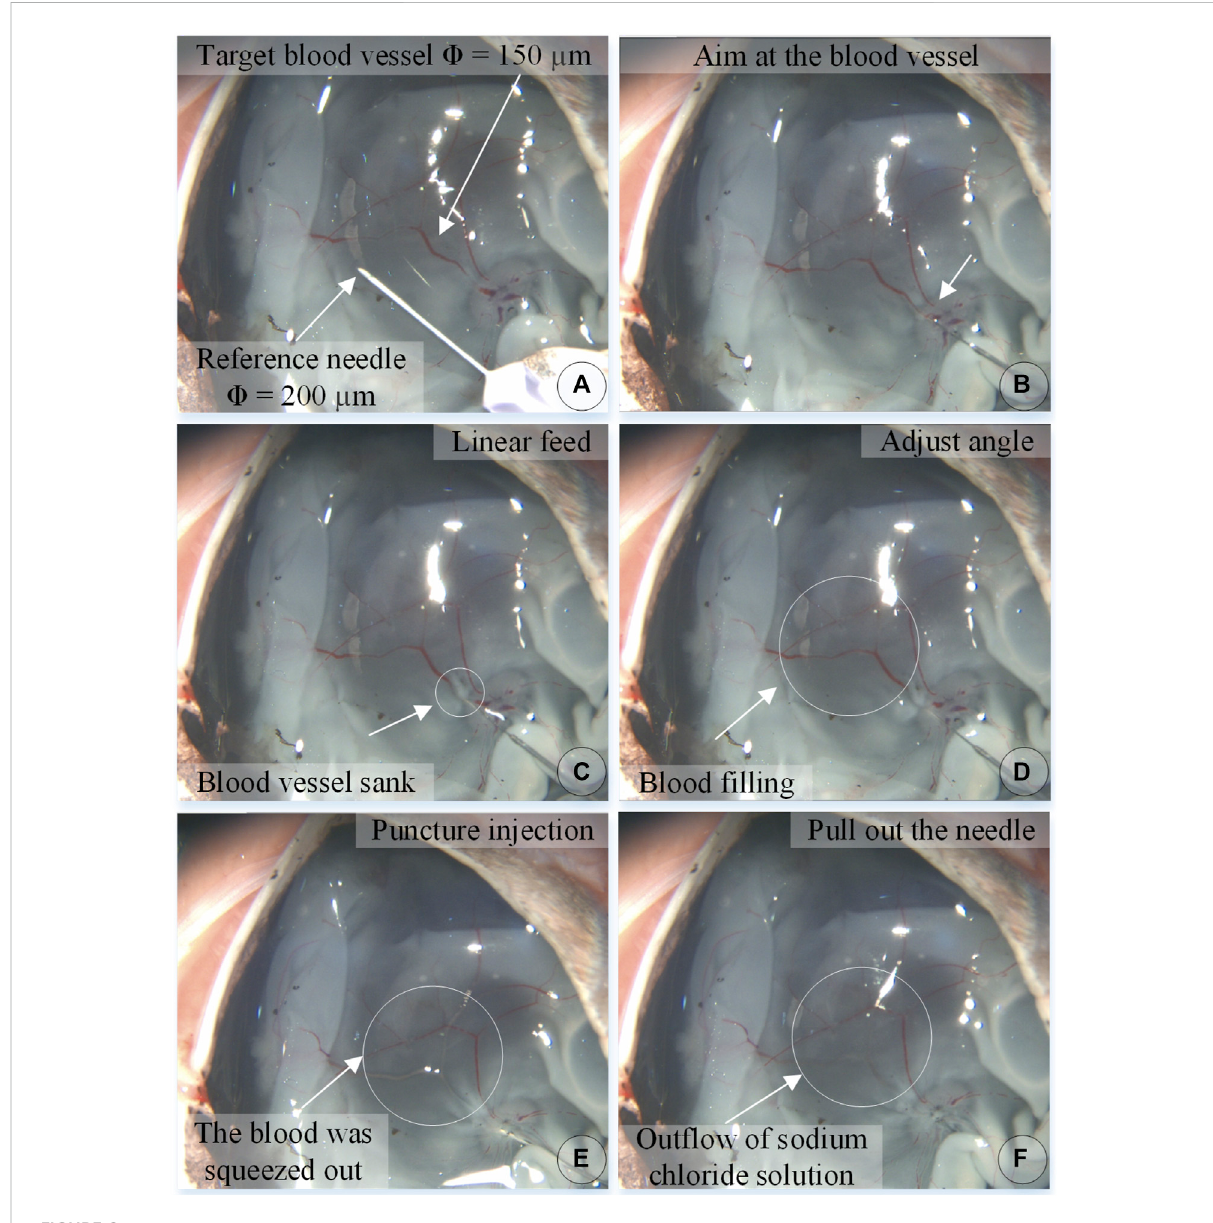
FIGURE 8 The puncture, injection and withdraw process of the isolated porcine eyeball retinal vein by microscopic images (A – F) .